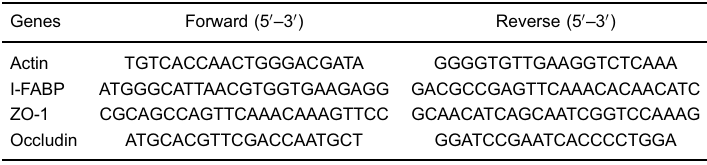
Table 1 . Primer sequences used for RT-qPCR